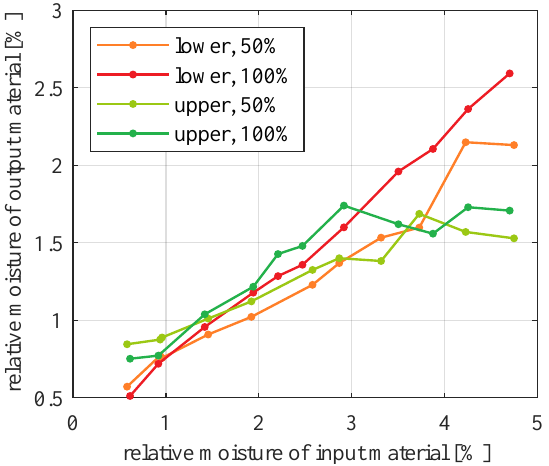
Figure 13. Comparison of measured moisture (average values) for lower and upper product of classification, for 50% and 100% nominal feeder